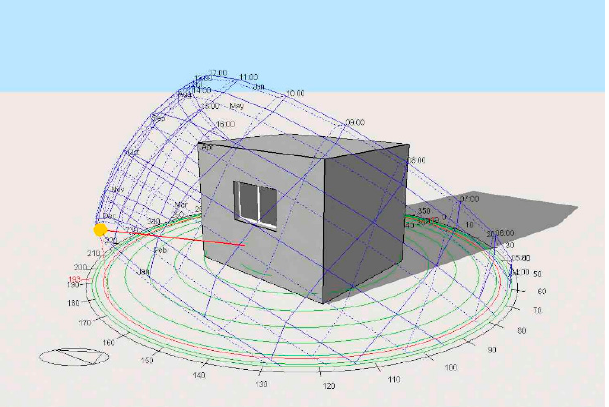
Figure 2. The geometric model of the LSF test cell considered in the dynamic simulations .